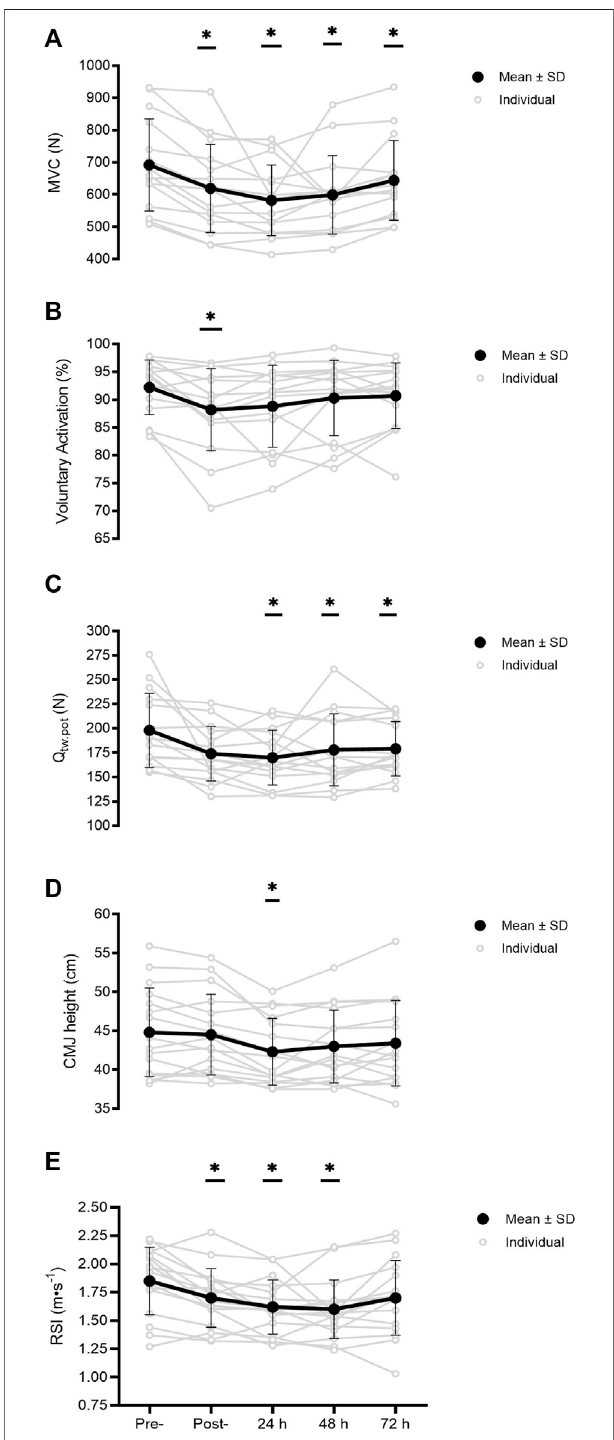
FIGURE 2 | MVC, maximal voluntary force (A) VA, voluntary activation (B) Q tw.pot , quadriceps potentiated twitch force (C) CMJ, countermovement jumpheight (D) andRSI,reactivestrengthindex (E) measuredpre-,post-,and at 24, 48, and 72 h post-training ( n = 16). Signi fi cant differences in comparison with baseline indicated by * p < 0.05. Individual responses are plotted with grey circles and lines, with black dots and connecting lines representing the mean scores, and error bars representing the ±